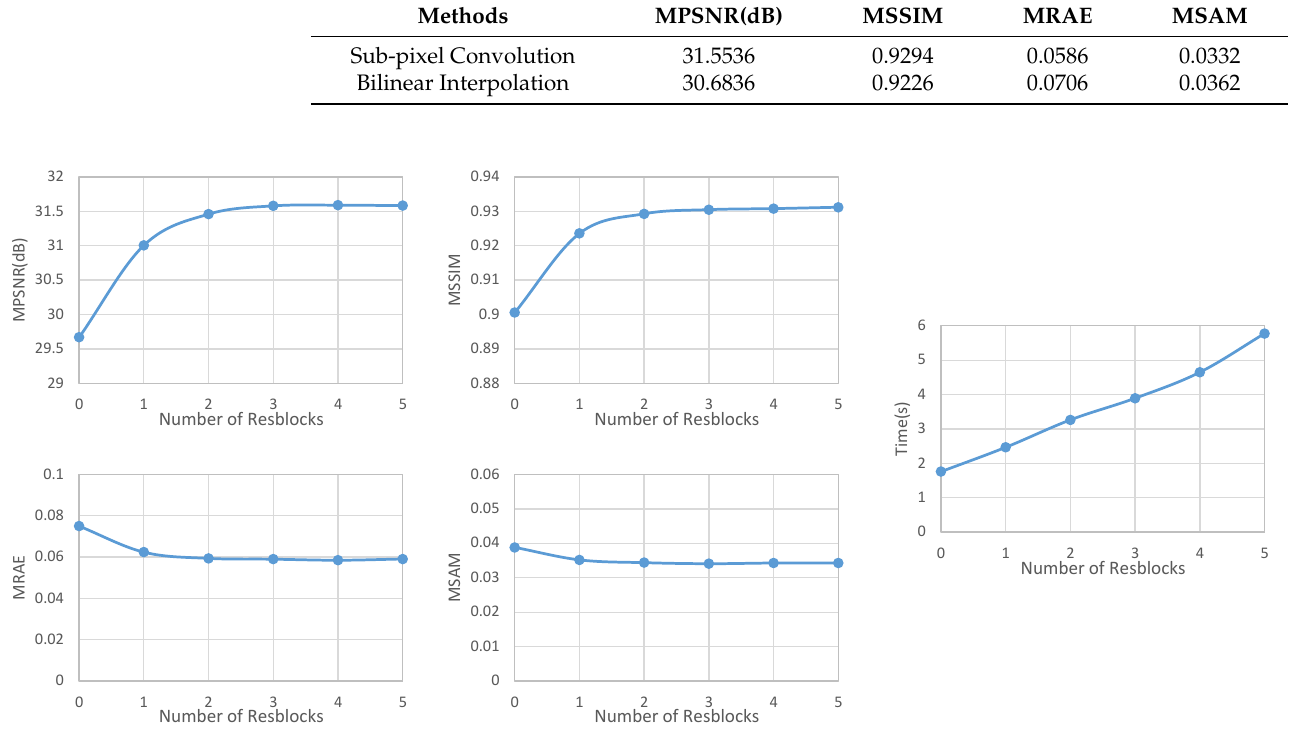
Figure 13. Performance of different number of Resblocks (average of all test